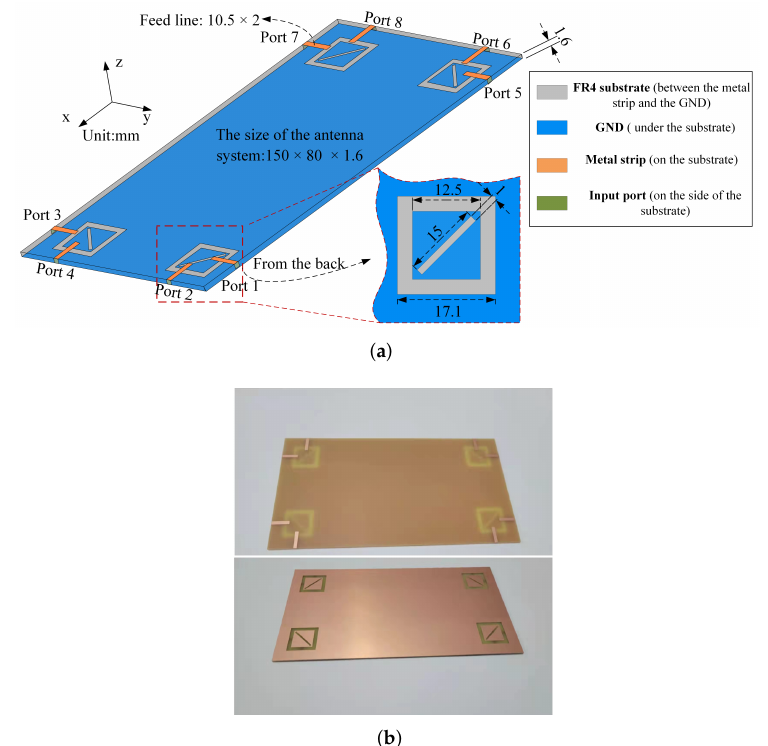
Figure 1. Configuration, dimensions, and photograph of the proposed eight-port antenna MIMO antenna. ( a ) Antenna configuration. ( b ) Photograph of the fabricated proposed antenna